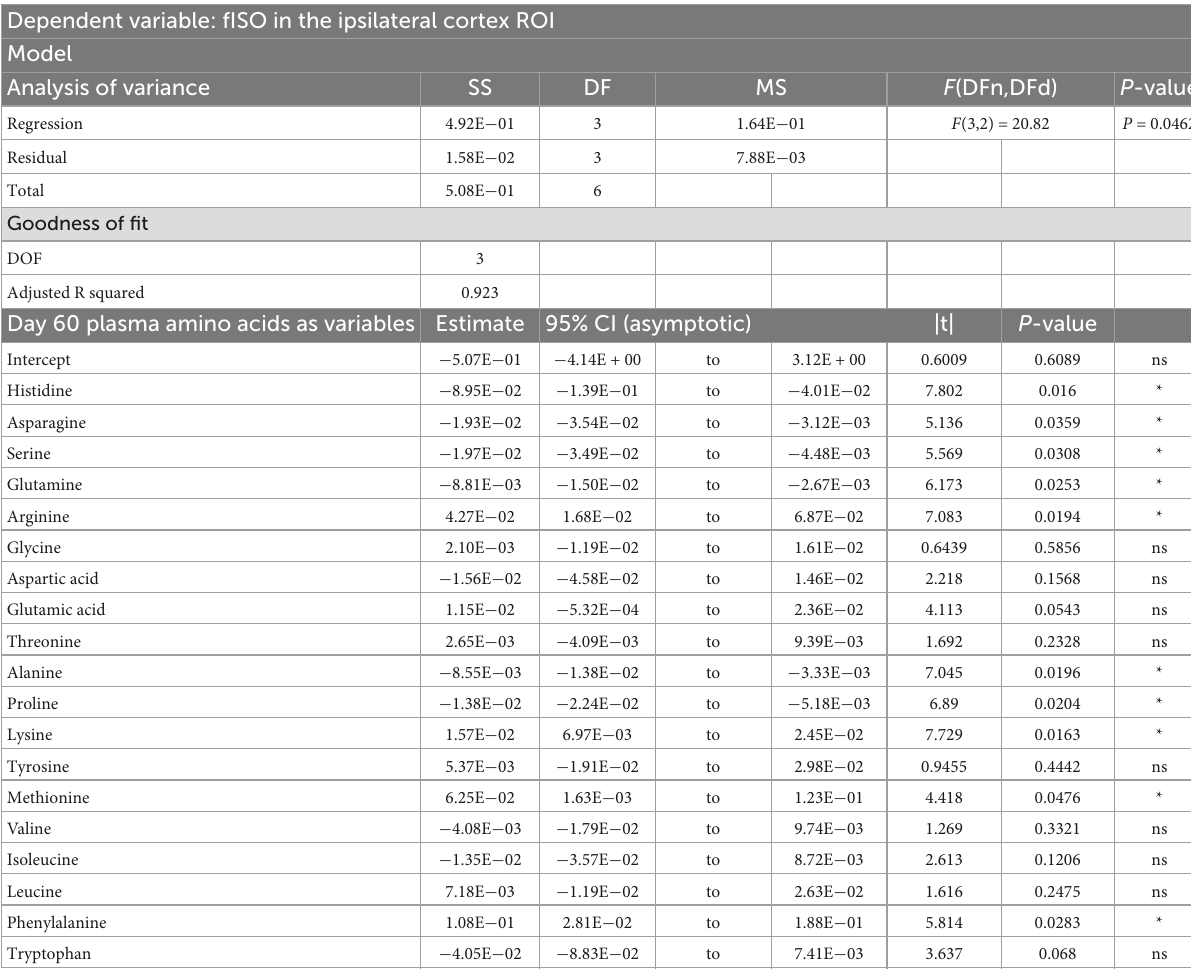
TABLE 6 Result of PCR predicting the fISO quantified from the ipsilateral cortex ROI from the plasma amino acid panel at day sixty post-injury. Dependent variable: fISO in the ipsilateral cortex ROI